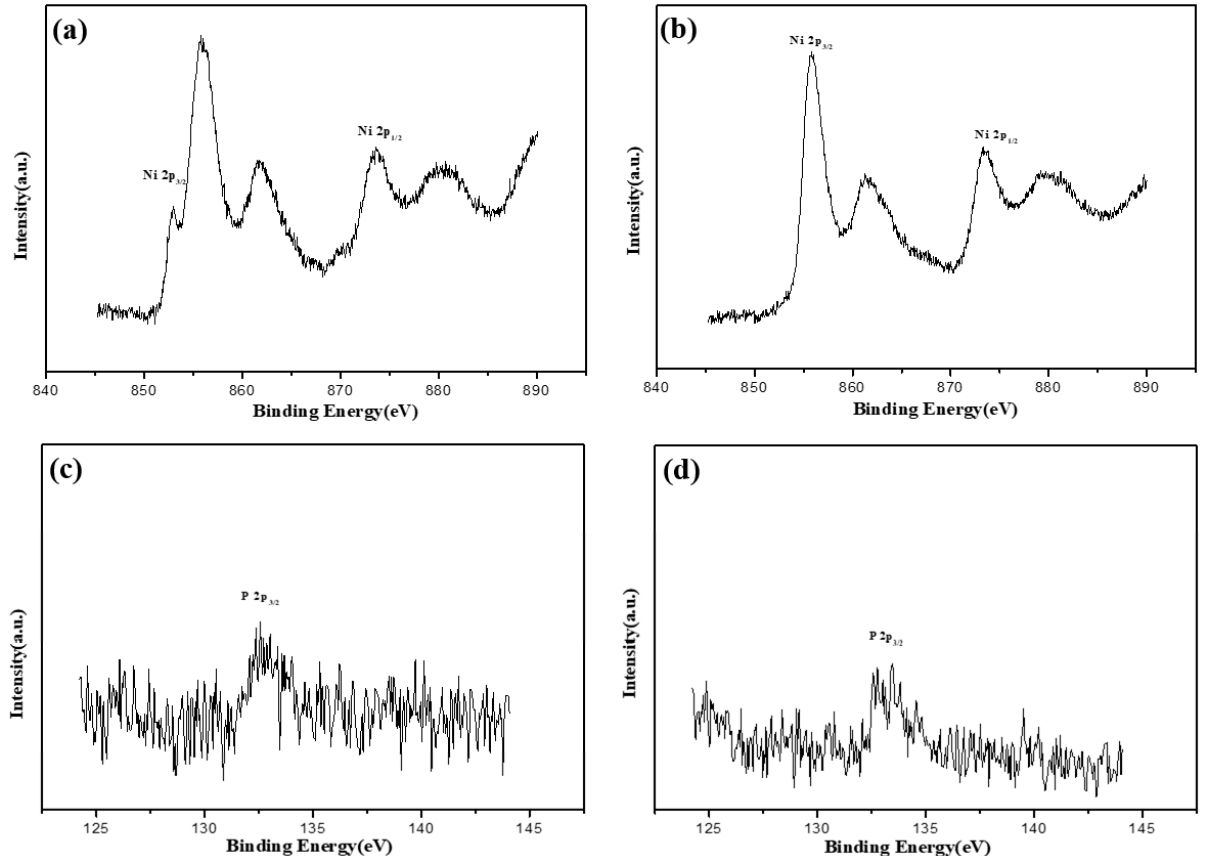
Figure 8. XPS analysis of Ni and P in the corroded coating with heat treatment at 400 °C. ( a ) XPS spectrum of Ni, ( b ) XPS spectrum of Ni element after etching for 30 s, ( c ) XPS spectrum of P, and ( d ) XPS spectrum of P after etching for 30 s.